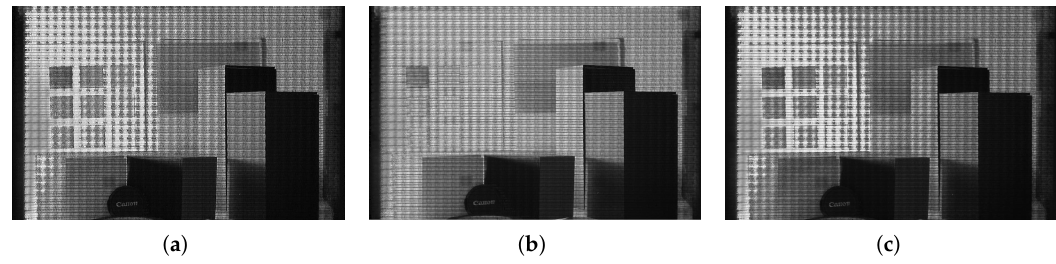
Figure 6. Results obtained from methods based on mode + mean ( a ) only mode ( b ), and mean of mode ( c